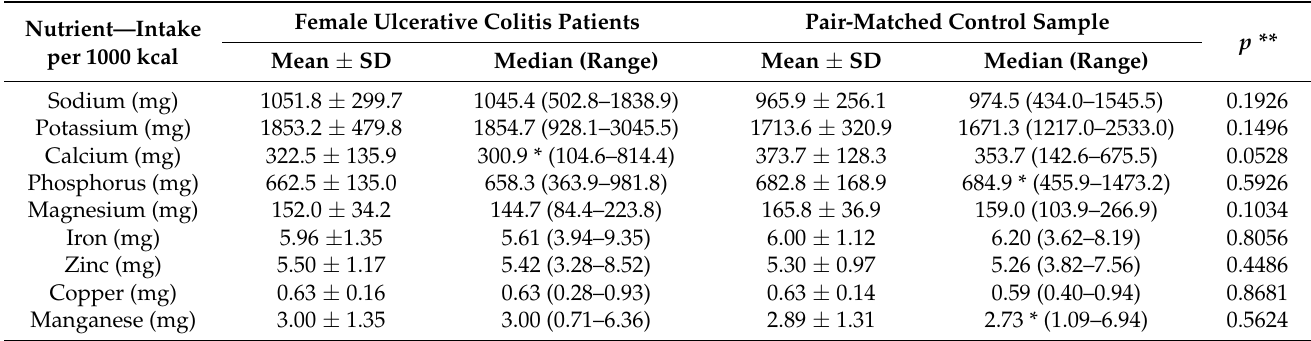
Table 4. The minerals intake recalculated per 1000 kcal in the studied Polish female ulcerative colitis individuals, in comparison with a pair-matched control